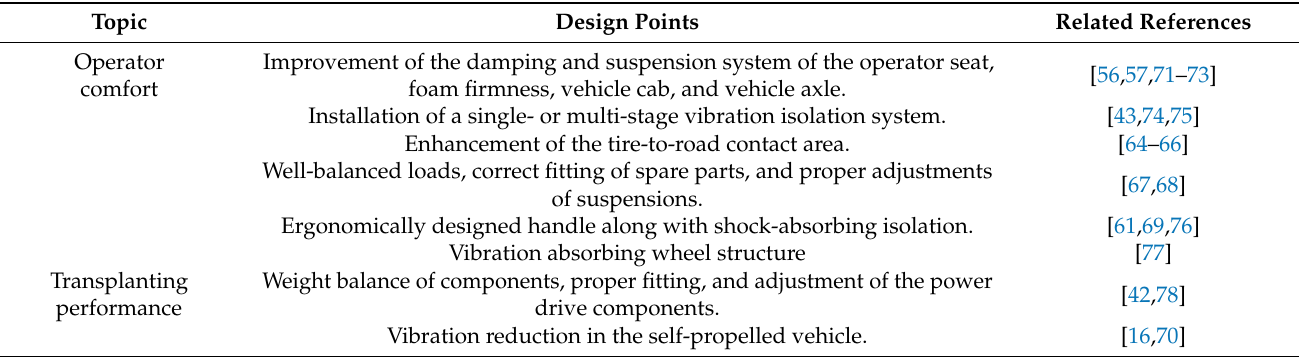
Table 9. Suggested design considerations to reduce the vibration exposure of the onion transplanter for the operator’s comfort and transplanting performance. Design